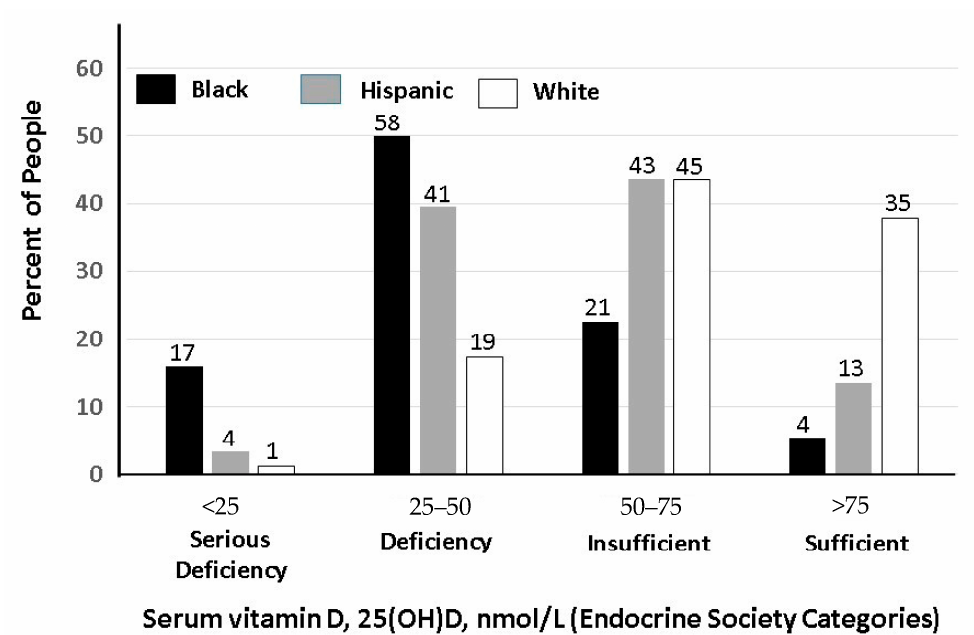
Figure 2. Prevalence of serum 25(OH)D levels in National Health and Nutrition Examination Survey (NHANES) survey, 2001–2010, by race/ethnicity category among nonusers of vitamin D supplements [35]. Additional calculations courtesy of X. Liu. Note: Divide by 2.5 to convert nmol/L to ng/mL.